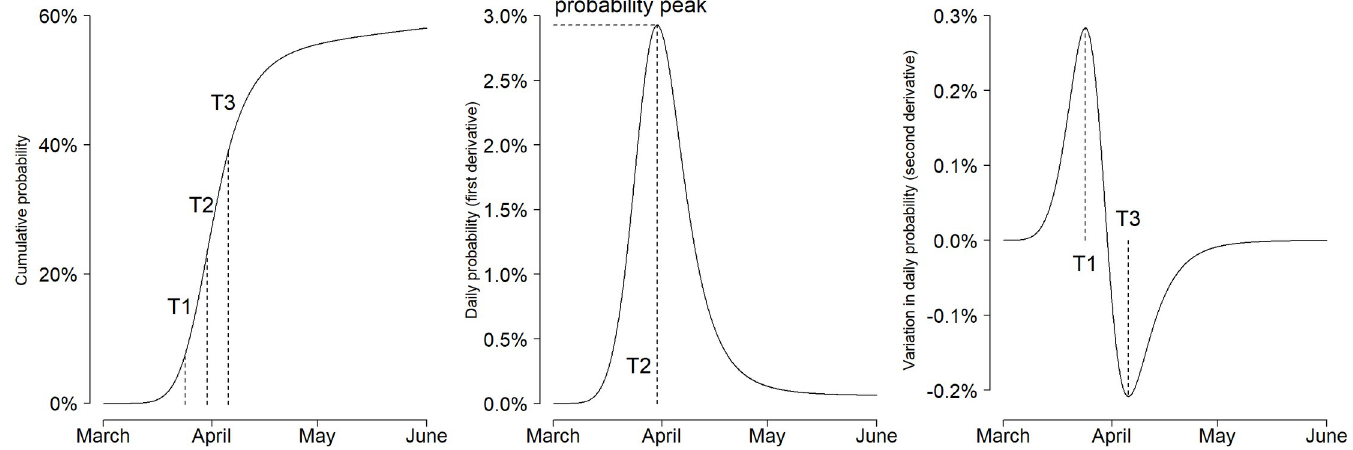
Fig 2. Curve of cumulative probabilities of COVID-19 outbreak in the nursing homes of Département Ain, Auvergne-Rhoˆne-Alpes Region, France, March 1–June 31, 2020. T1: delay to acceleration of the probability increase. T2: delay to the peak of outbreak probability. T3: delay to deceleration of the probability decrease, expressed in days since March 1,